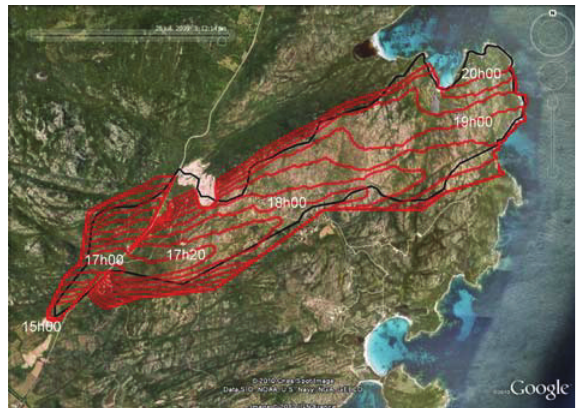
Figure 9: Simulated intermediate fire perimeters obtained with a nonconstant wind and observed final perimeter in black for Suartone